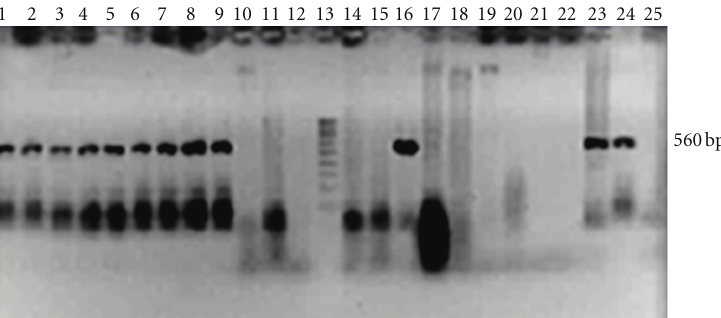
∗ Counts in Petri dish. ∗∗ Total soil samples or dishes.